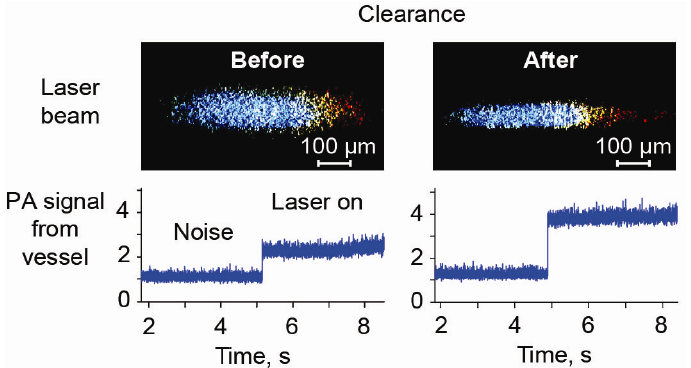
Figure 7. Laser beam after passing through 0.9 mm-thick layer of fresh mouse skin (top) and PA signals from a 1 mm-diameter, 1.3 mm vein (bottom) before (left) and after (right) optical clearance